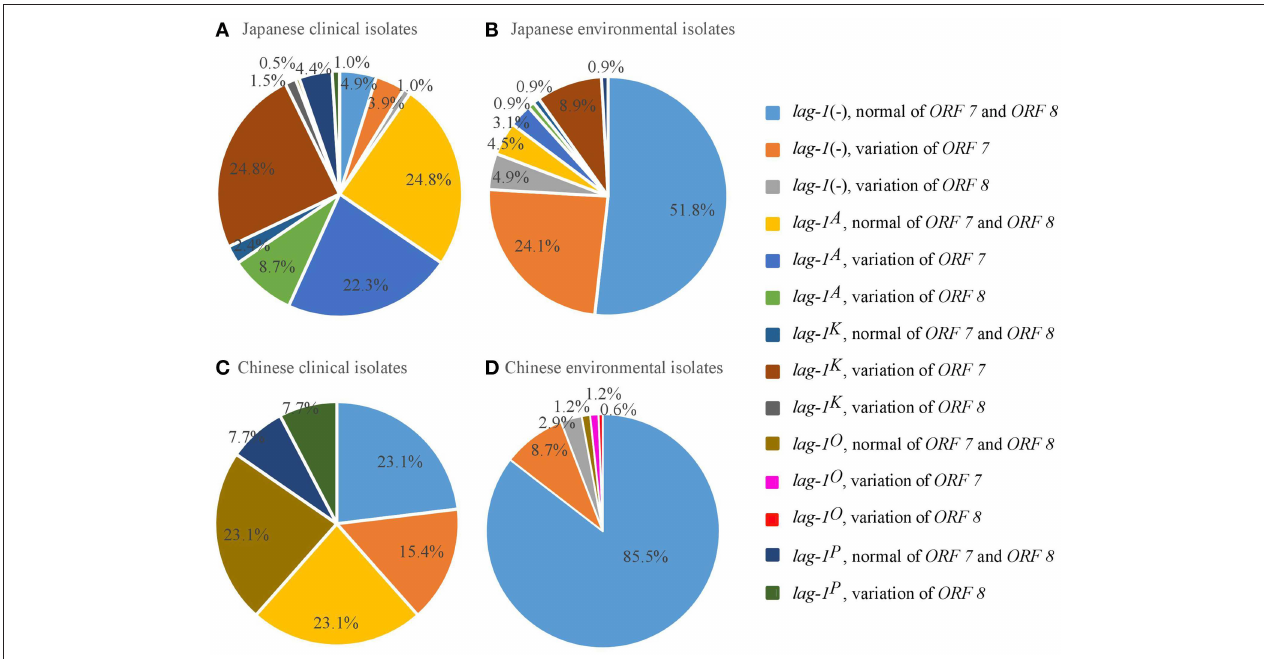
FIGURE 1 | Distribution of lag-1 alleles, and ORF 7 and ORF 8 genes of LPS among L. pneumophila serogroup 1 isolates from Japan and China. (A) Distribution of lag-1 alleles, ORF 7 and ORF 8 genes of LPS among Japanese clinical isolates (A) , Japanese environmental isolates (B) , Chinese clinical isolates (C) , and Chinese environmental isolates (D)